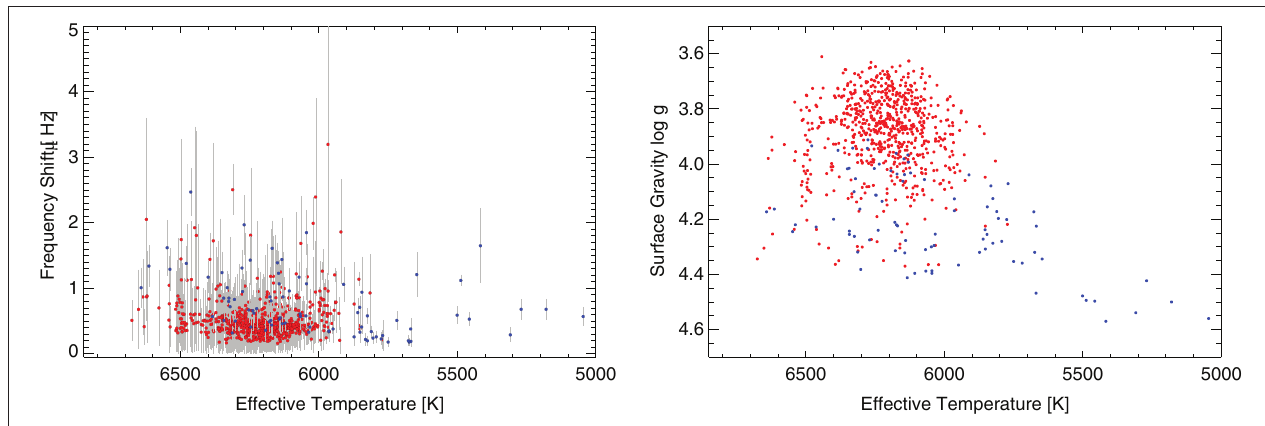
FIGURE 6 | (Left) : Significant frequency shifts from region I of the synthetic TESS data as function of effective temperature in red. A 4 year extension of the TESS mission is assumed and the error bars of the CC method are halved to approximate the PB method. Significant frequency shifts found by Santos et al. (2018) are shown in blue. (Right) : Kiel diagram of the stars which are included in the left